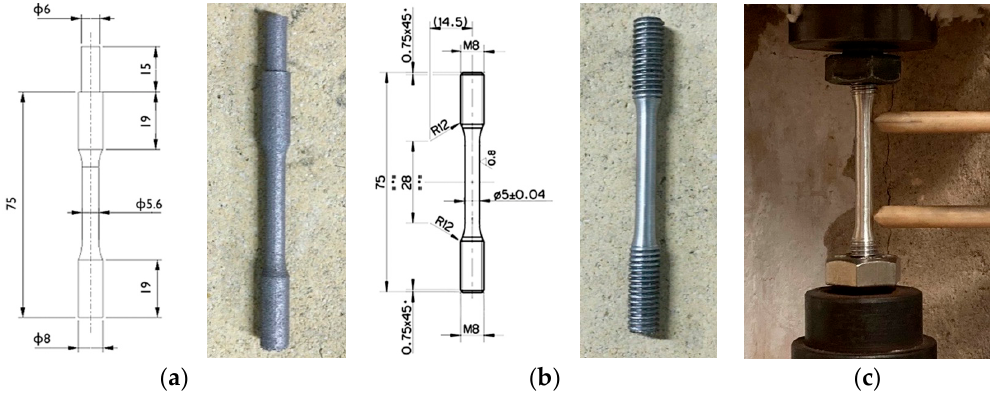
Figure 2. Tensile samples geometry and dimensions: ( a ) near-net-shape sample obtained by PBF-LB process, ( b ) final sample after machining. In ( c ): equipment for tensile tests. Table 3. Heat treatments (optimized in [25]) and tensile test